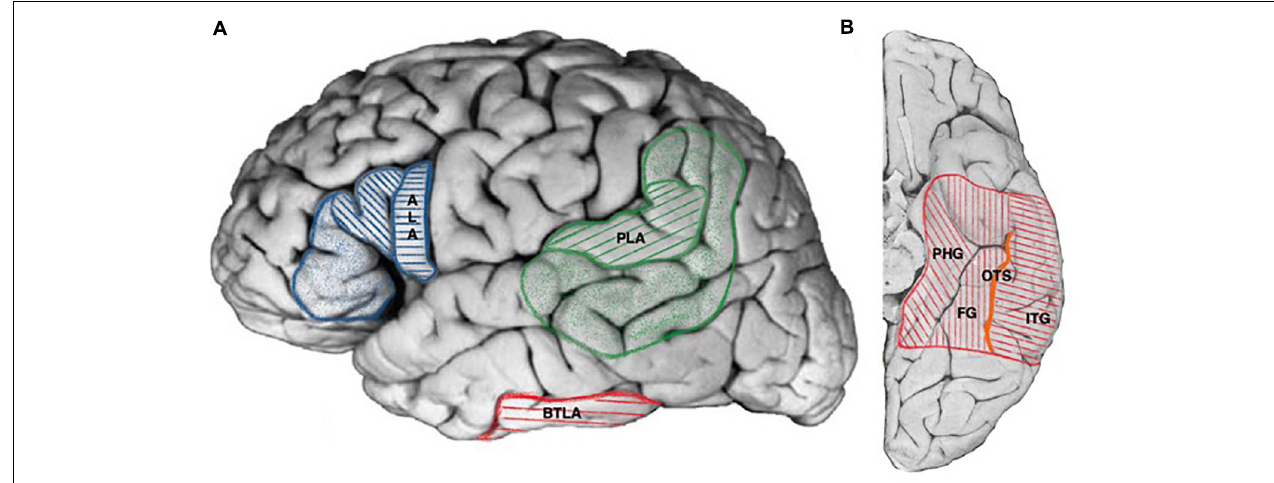
FIGURE 1 | Cortical projections of human language areas. Hatched areas for projections common to all publications, colored areas for extended and debated limits (see text for details). (A) Lateral view, ALA, anterior language area (blue, hatched areas: pars opercularis, pars triangularis of the frontal operculum; colored areas: pars orbitalis of the frontal operculum), PLA, posterior language area (green hatched areas: posterior part of the superior temporal gyrus, angular gyrus, colored areas: posterior part of the middle temporal gyrus including the inferior temporal sulcus, supra-marginal gyrus, part of the angular gyrus), BTLA, basal temporal language area (red). (B) Ventral view, BTLA (red hatched area). PHG, parahippocampal gyrus; FG, fusiform gyrus; ITG, inferior temporal gyrus; OTS, occipito-temporal sulcus